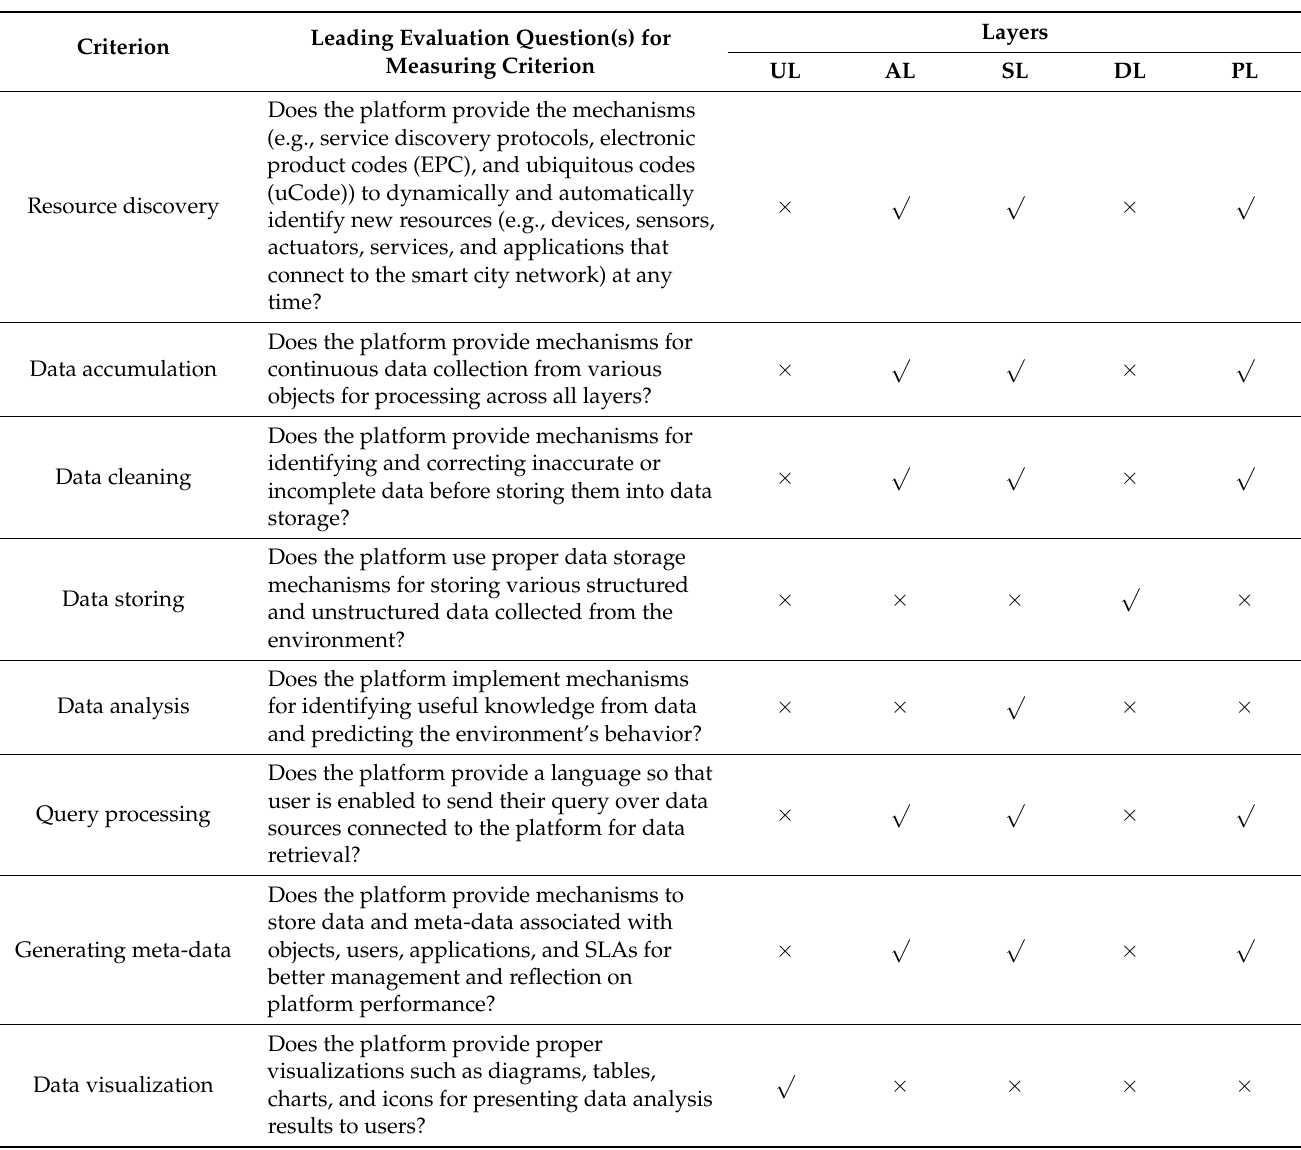
Table 3. Criteria related to assessing IoT platform functions (UL: user interface layer, AL: application layer, SL: service layer, DL: data layer, PL: physical layer,